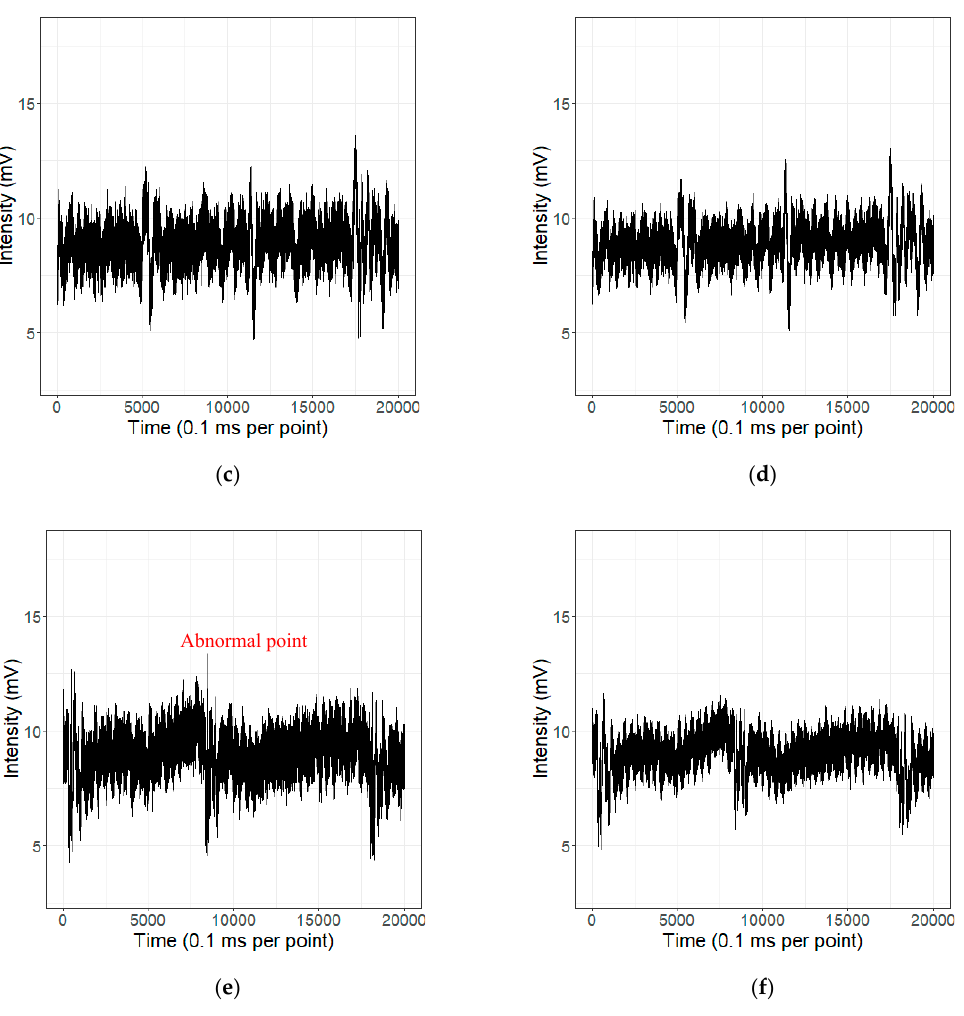
Figure 9. The enhancement and reconstruction of three types of typical signals: ( a ) standard knock, ( b ) reconstructed standard knock, ( c ) walk, ( d ) reconstructed walk, ( e ) manual mining, and ( f ) reconstructed manual mining.